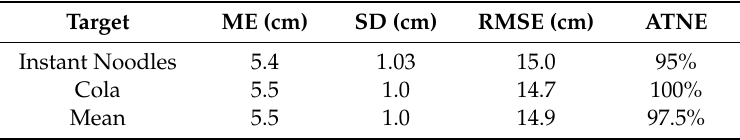
Table 2. Statistics of multiple target localization